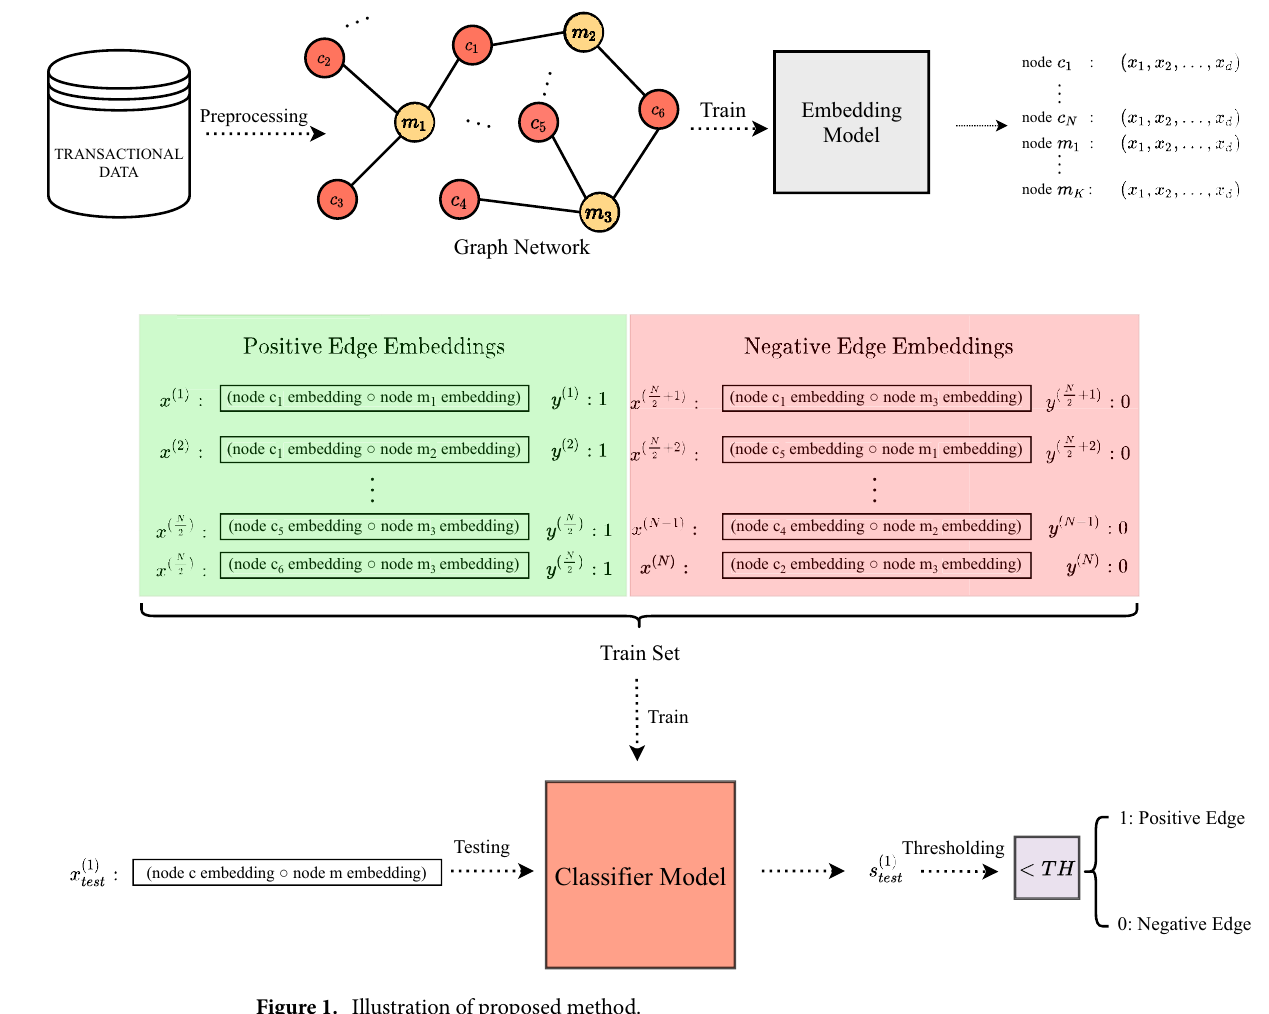
Figure 1. Illustration of proposed